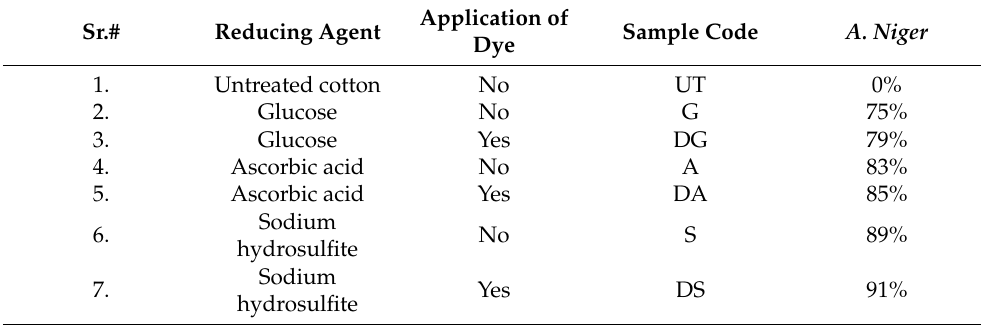
Table 8. Reduction percentages in antifungal activity.